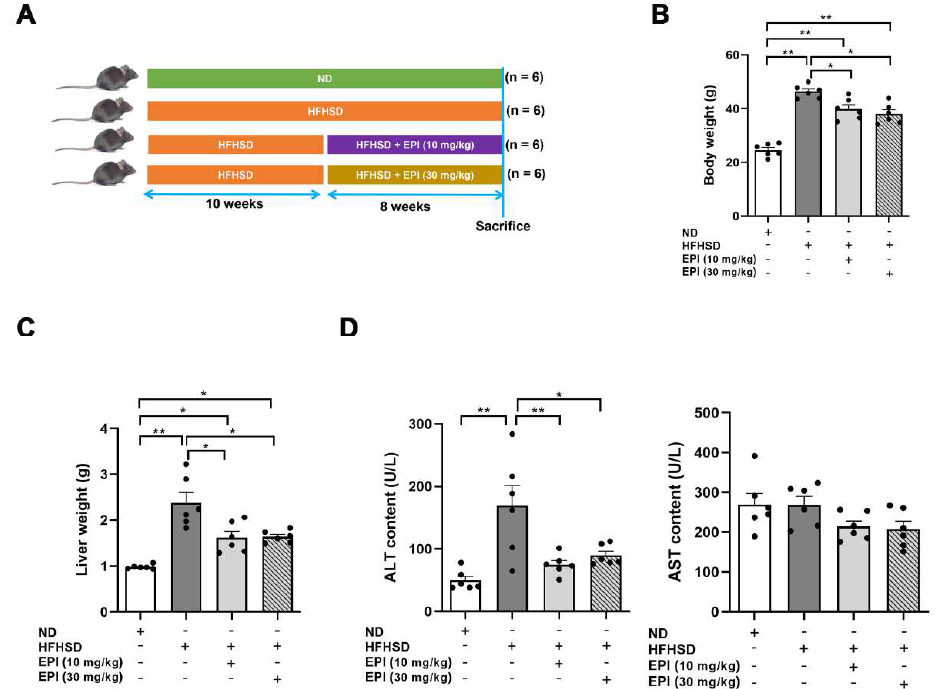
Figure 2. EPI (EPI-001) application ameliorates HFHSD-induced hepatic steatosis. ( A ) Scheme for experiment strategy on a normal diet (ND) or high-fat-high-sugar diet (HFHSD), or HFHSD with EPI treatment (HFHSD + EPI); ( B ) The body weight of mice; ( C ) The wet liver weight of mice; ( D ) The serum levels of ALT and AST in mice (mean ± SEM, * p < 0.05, ** p < 0.01, n =